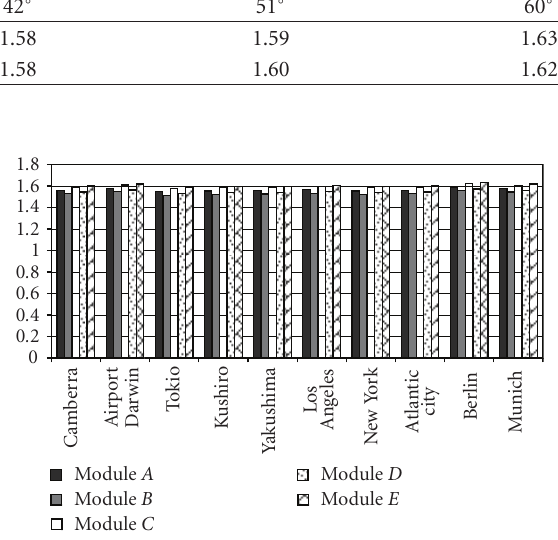
Figure 4: Current factor average values ( F I ) for di ff erent types of modules located in di ff erent